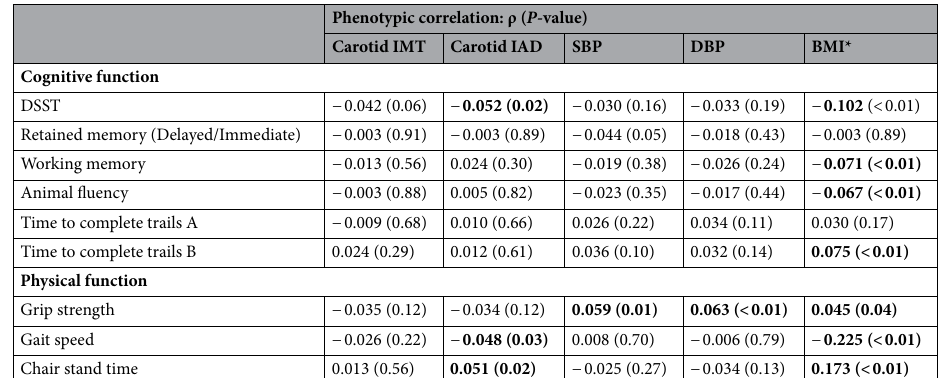
Table 3. Adjusted phenotypic correlations between CVD risk factors and cognitive and physical function. Values shown are correlation estimates ( P -values) between CVD risk factor and cognitive or physical function measure as estimated by SOLAR. BOLD indicates a statistically significant correlation ( P < 0.05). Covariate adjustments : age, age 2 , sex, field centers, height, weight, and whether an individual currently smokes. *BMI models do not include adjustment for height or weight.